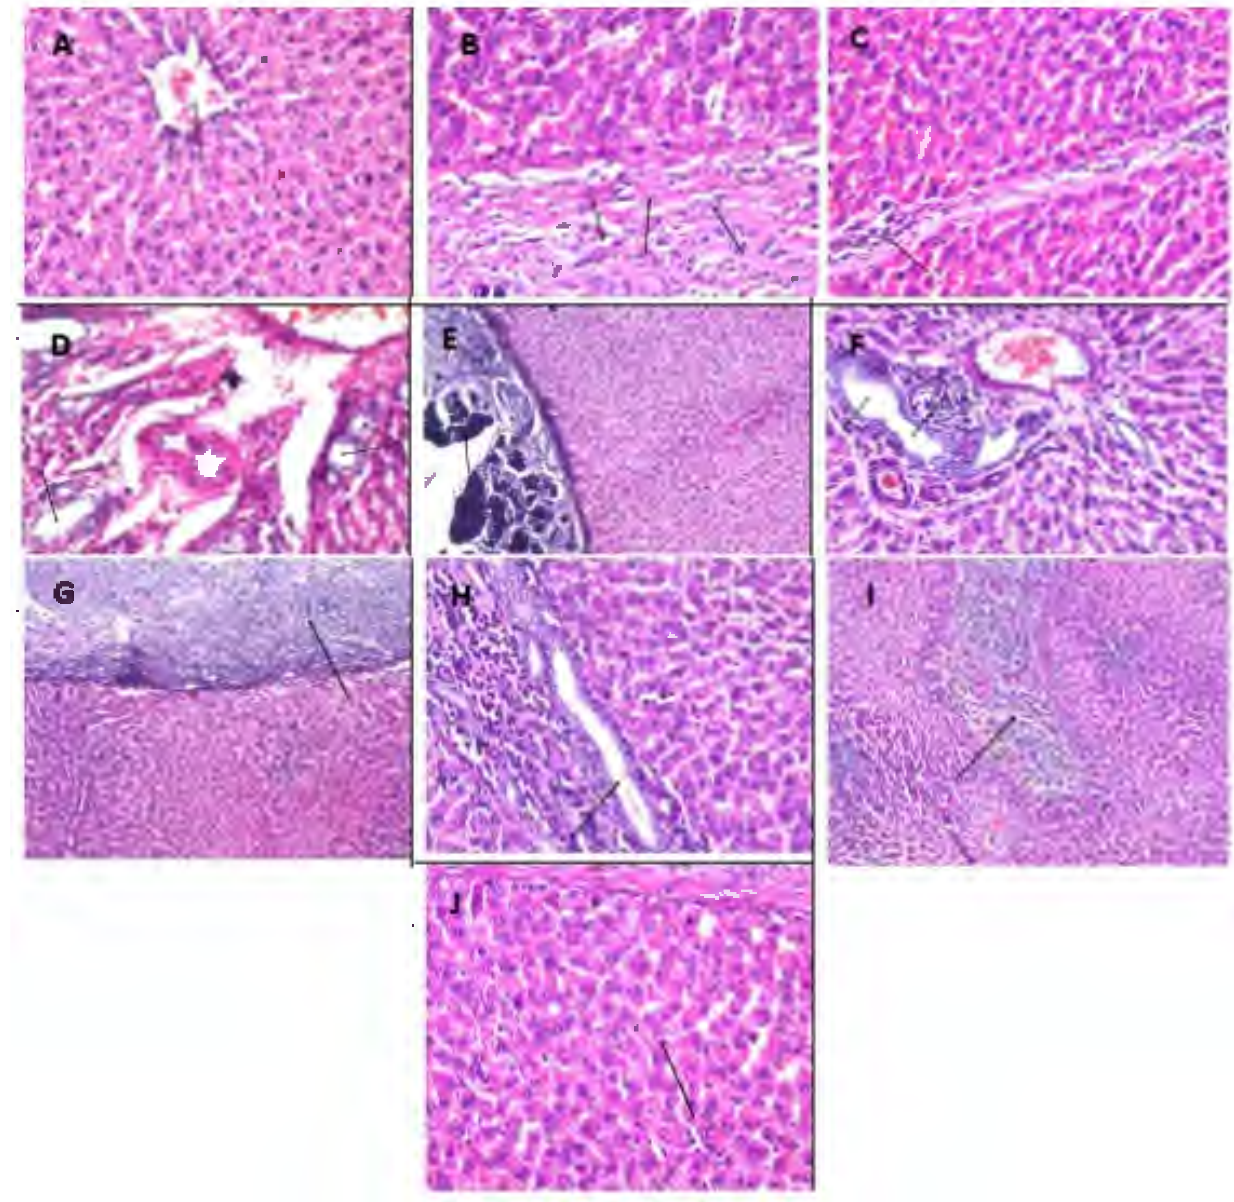
Figure 2. Photomicrographs of hepatic tissue specimens stained by H & E ( × 40). Photomicrograph ( A ) Transverse hepatic tissue section from the control group showing the histological structure of the central vein and surrounding hepatocytes in the parenchyma. Photomicrographs ( B – D ) Transverse hepatic tissue section from AlCl 3 -treated animals showing the hepatic capsule was thick due to fibrous connective tissue proliferation and inflammatory cell infiltration ( B ), strands of fibrous tissue formation with inflammatory cells infiltration were extended in between the hepatocytes ( C ). The portal area showed congestion in the portal vein with multiple newly formed bile ductules ( D ) (arrows). Photomicrographs ( E , F ): Transverse hepatic tissue section from the fluoxetine-treated animals showing Glisson’s capsule with fibrosis and inflammatory cells infiltration as well as calcification ( E ) associated with inflammatory cells infiltration in the portal area ( F ) (arrows). Photomicrographs ( G – I ) : Transverse hepatic tissue section from the wheatgrass group showing Glisson’s capsule with fibrosis, thickening, and inflammatory cells infiltration ( G ), while the portal area had hyperplasia in the bile ducts with inflammatory cells infiltration in between ( H ). There was focal necrosis in the parenchyma ( I ) (arrows). Photomicrograph ( J ): Transverse hepatic section from the combination group showing no histopathological